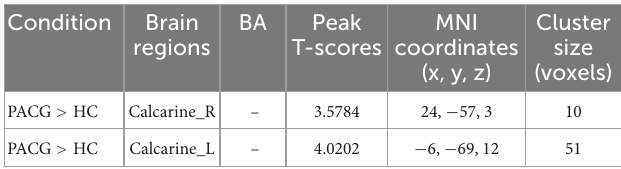
TABLE 2 Different dynamic functional connectivity (dFC) values in the left V1 between two groups. Condition